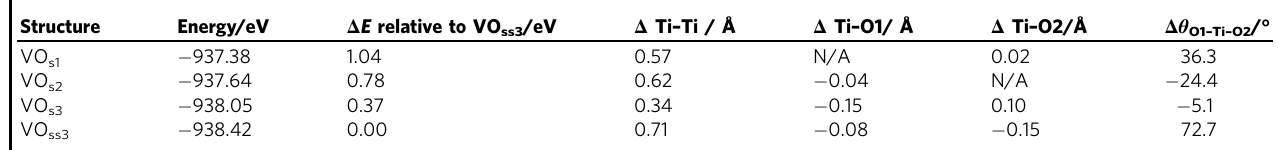
Table 3 DFT results showing the absolute energy, relative energy to minimum structure VO ss3 , and changes in local bond distances and bond angles relative to the pristine anatase (101)